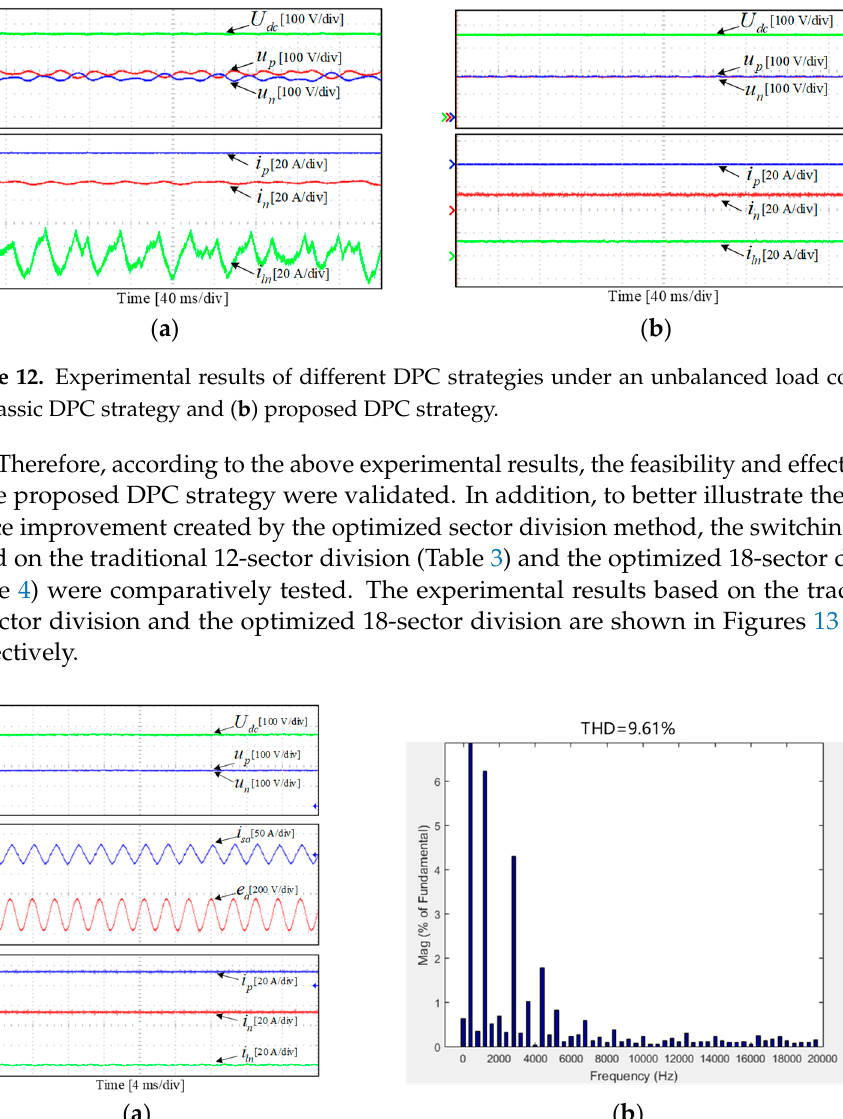
( b ) Figure 14. Experimental results based on the optimized 18-sector division. ( a ) Voltage and current waveforms of TCIBAR and ( b ) fast Fourier transform (FFT) results of the phase current.